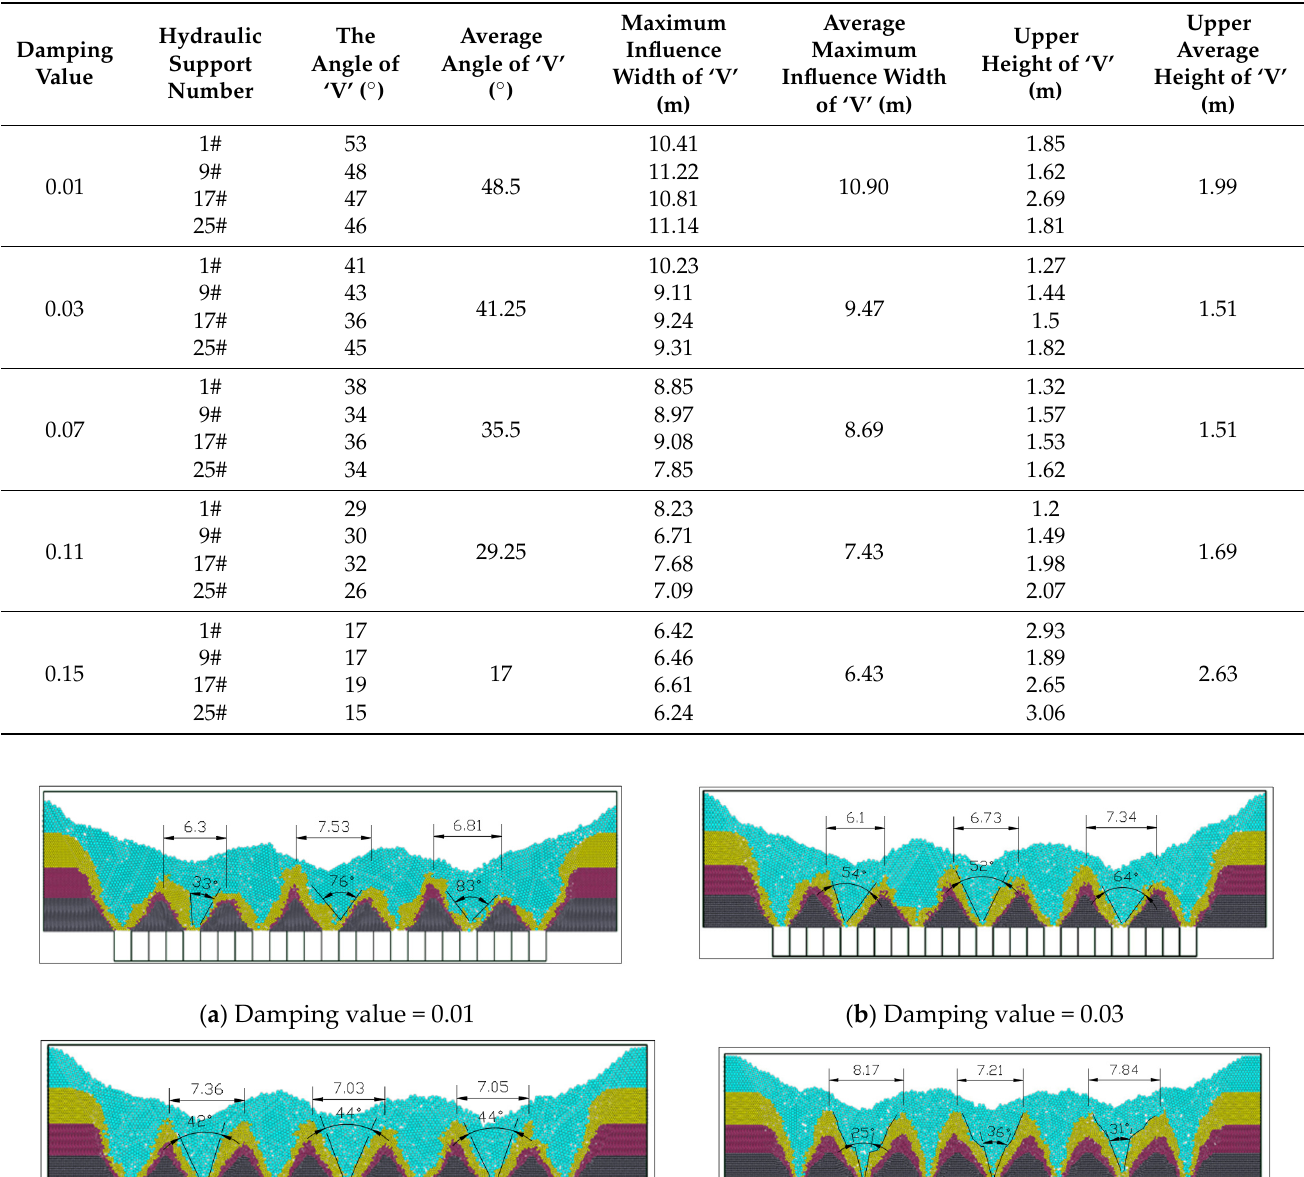
Table 3. Characteristics of top-coal drawing funnel after level 1 caving.